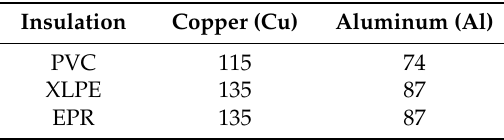
Table 4. Value of the short-circuit constant K